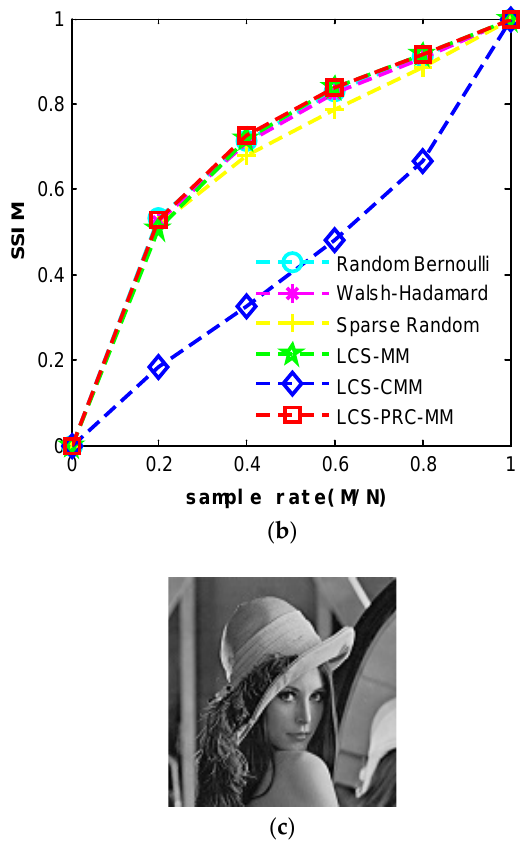
Figure 3. Comparison of reconstruction of the target image with the TVAL3 recovery algorithm under different measurement matrices: ( a ) analysis of reconstruction results by using peak signal-to-noise ratio (PSNR), ( b ) analysis on reconstruction results by using structural similarity (SSIM), and ( c ) target image.